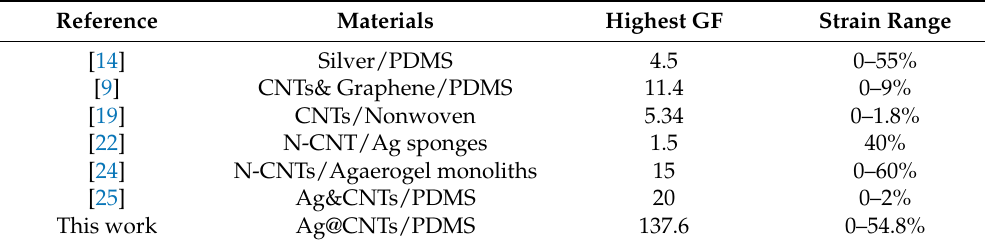
Table 1. Research status of the strain sensors based on silver and